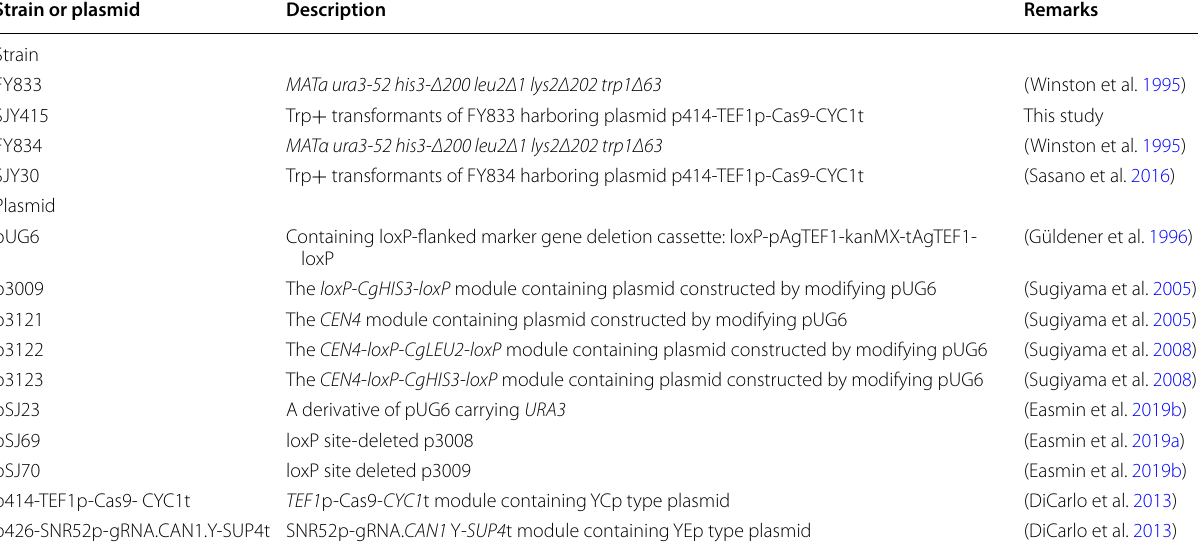
Table 1 Strains and plasmids used in the CRISPR-PCDup experiments Strain or